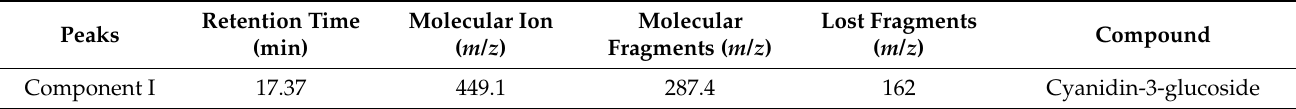
Table 1. Identify of the component I using HPLC-ESI-MS/MS.